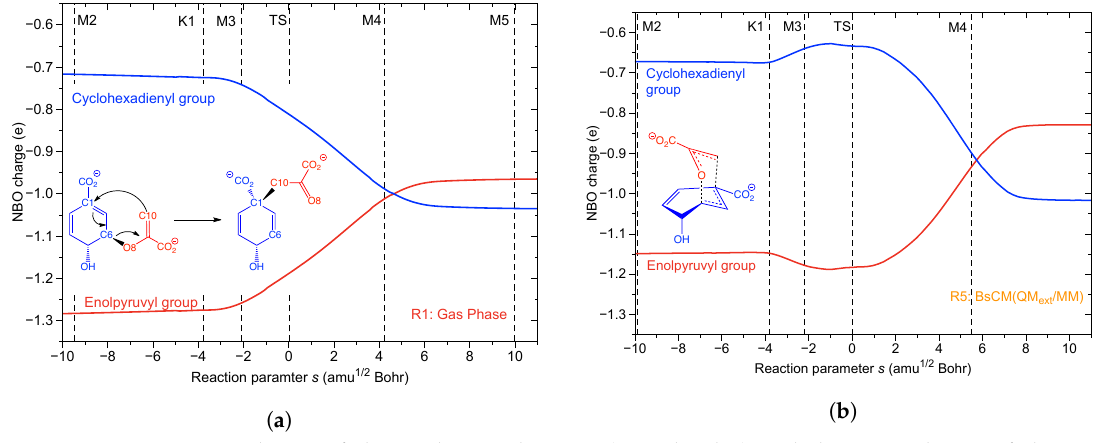
Figure 11. NBO charge of the enolpyruvyl group (in red color) and the NBO charge of the 4-hydroxy-1,5-cyclohexdiene-1-carboxylate group (in blue color) as function of the reaction parameter s for the reactions R1 ( a ) and R5 ( b ). The TS at s = 0 amu 1/2 Bohr is indicated by a vertical dashed line. (Reprinted with permission from [118]; copyright 2020 from Taylor and Francis).